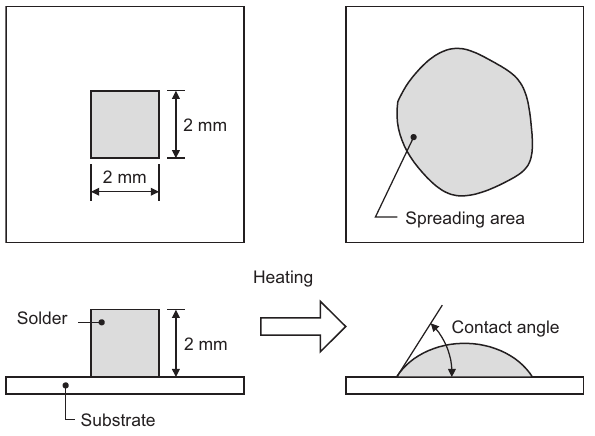
Figure 1 Schematic drawing of a method for measuring contact angle and spreading